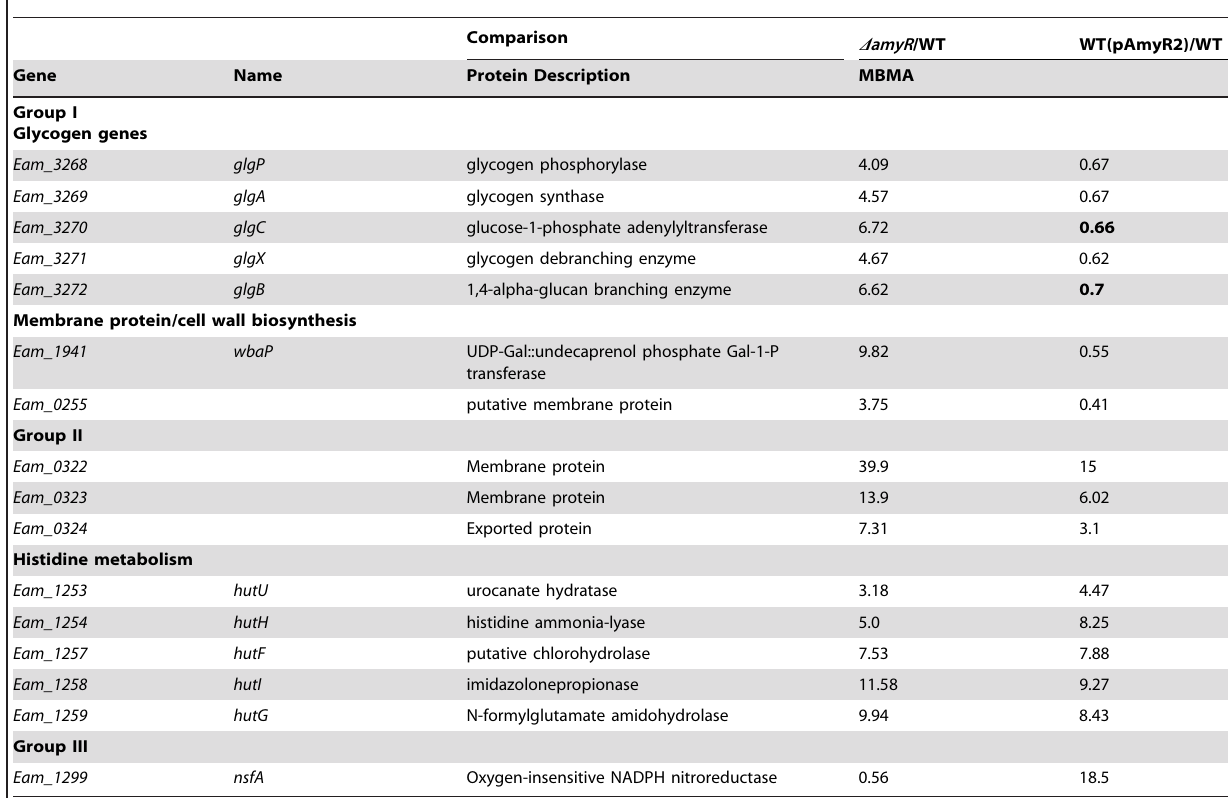
Table 2. Expression ratios of selected membrane, glycogen, and metabolism